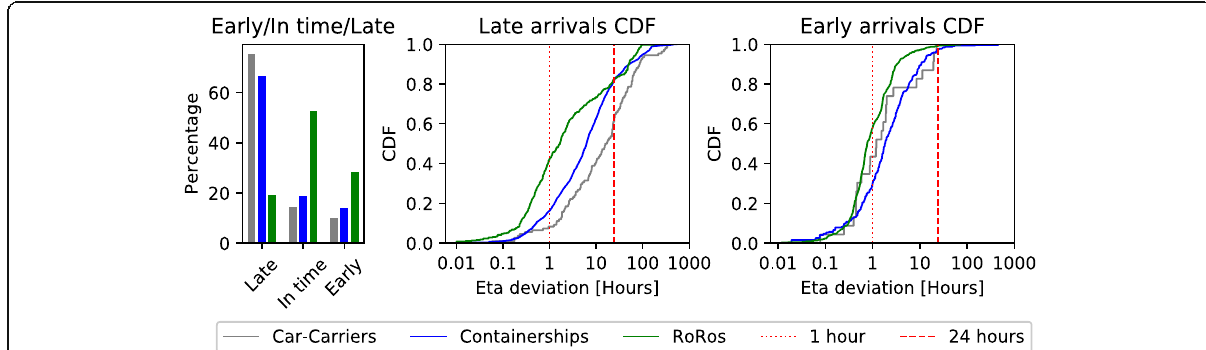
Fig. 7 ETA Deviation for Car-Carriers, Containerships and RoRos.(Left) shows the early/late arrivals ratio. (Center) and (Right) show the CDFs for the early and late arrivals respectively